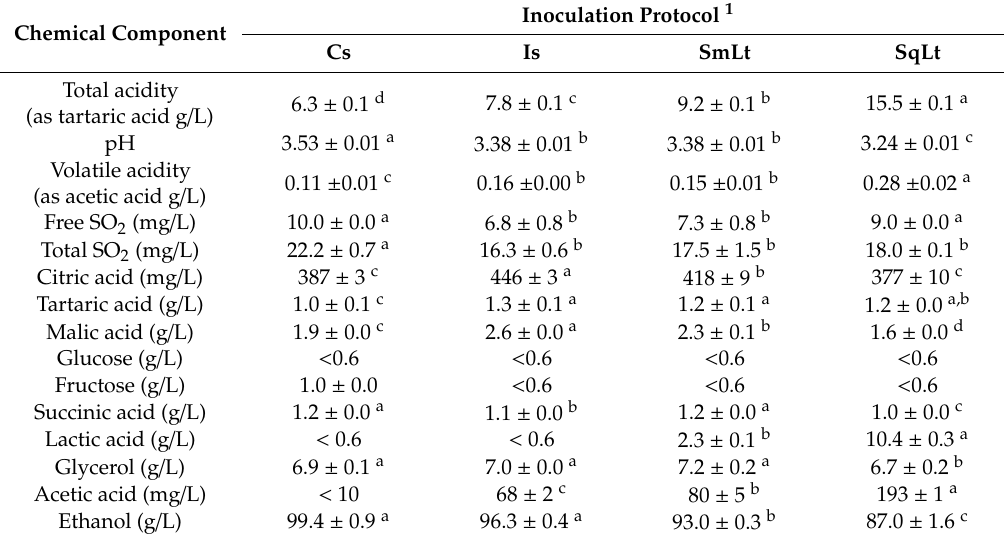
Table 2. Chemical characteristics of wines produced from pasteurized grape must (mean ± SD, n = 3). Values with different superscript letters within each row differ significantly ( p < 0.05).